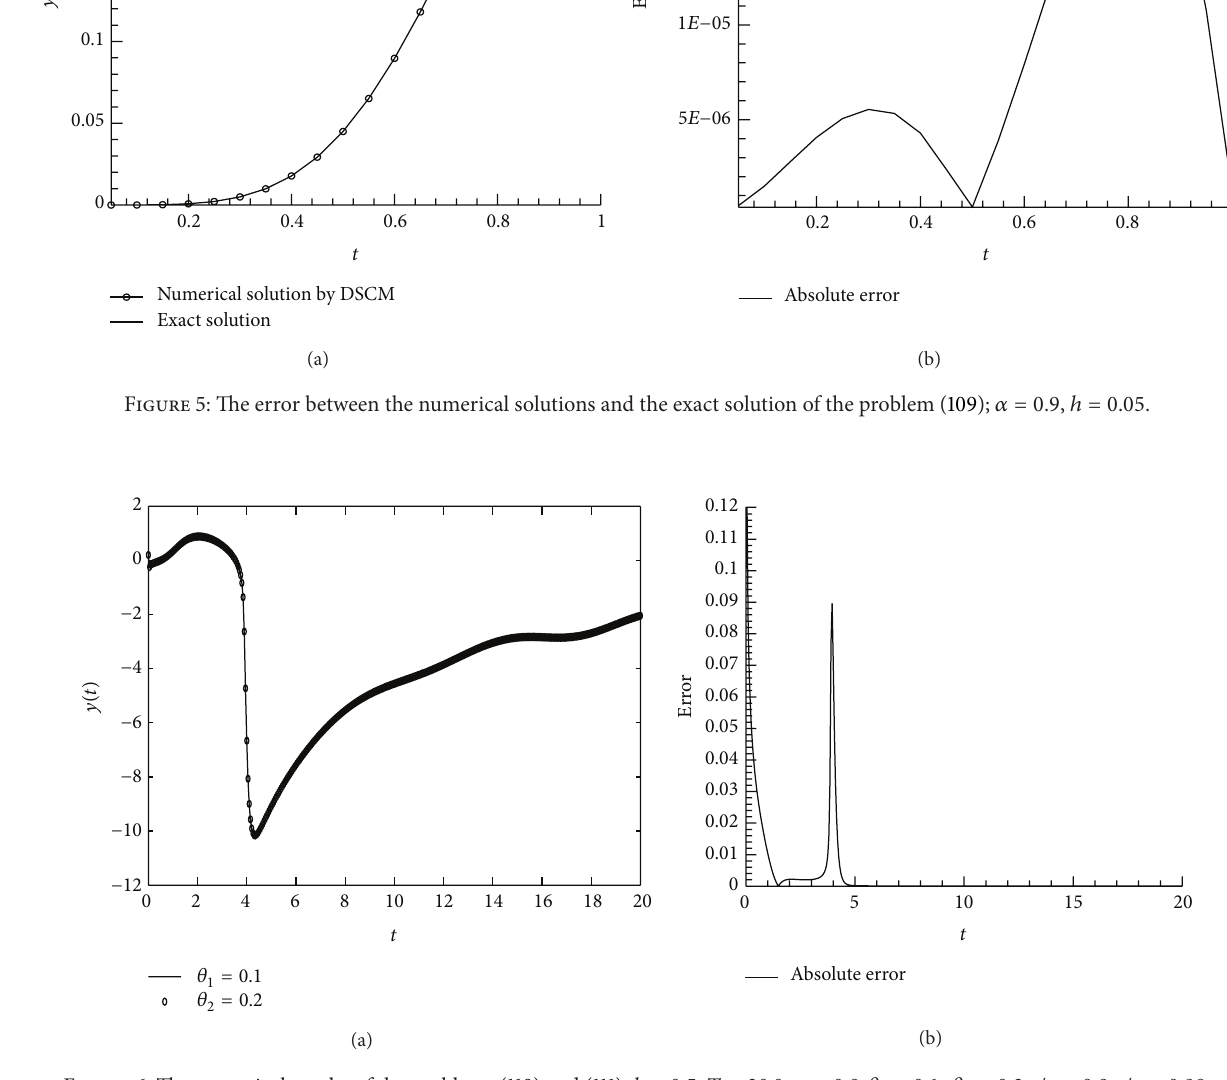
Figure 6: The numerical results of the problems (110) and (111); ℎ = 0.5 , 𝑇 = 20.0 , 𝛼 = 0.8, 𝜃 1 = 0.1, 𝜃 2 = 0.2, 𝜙 1 = 0.9, 𝜙 2 = 0.98